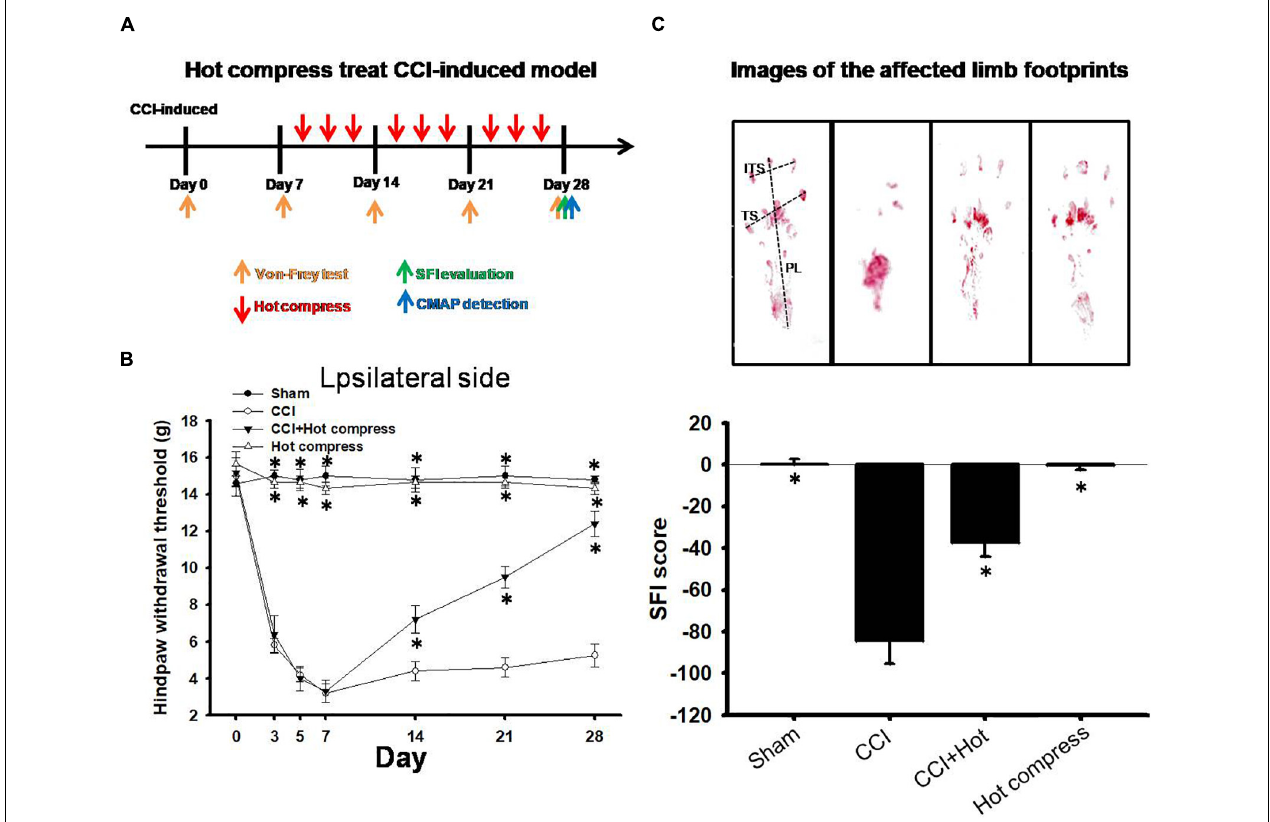
FIGURE 3 | Hot compress may relieve CCI-induced neuropathic pain. (A) Schematic view of hot compress treatment process. (B) Thresholds for hindpaw withdrawal responses to the Von Frey filament stimulation on the ipsilateral site in sham, CCI, CCI + hot compress, and hot compress alone groups. Two-way ANOVA with Bonferroni post hoc test. (C) Footprints and determination of the sciatic functional index (SFI) in sham, CCI, CCI + hot compress, and hot compress alone groups, the data were analyzed by one-way ANOVA with post hoc Dunnett’s test. ∗ p < 0.001 was considered significant as compared with the CCI group, n = 8. The factors for SFI included the print length (PL), toe spread (TS), and intermediary toe spread